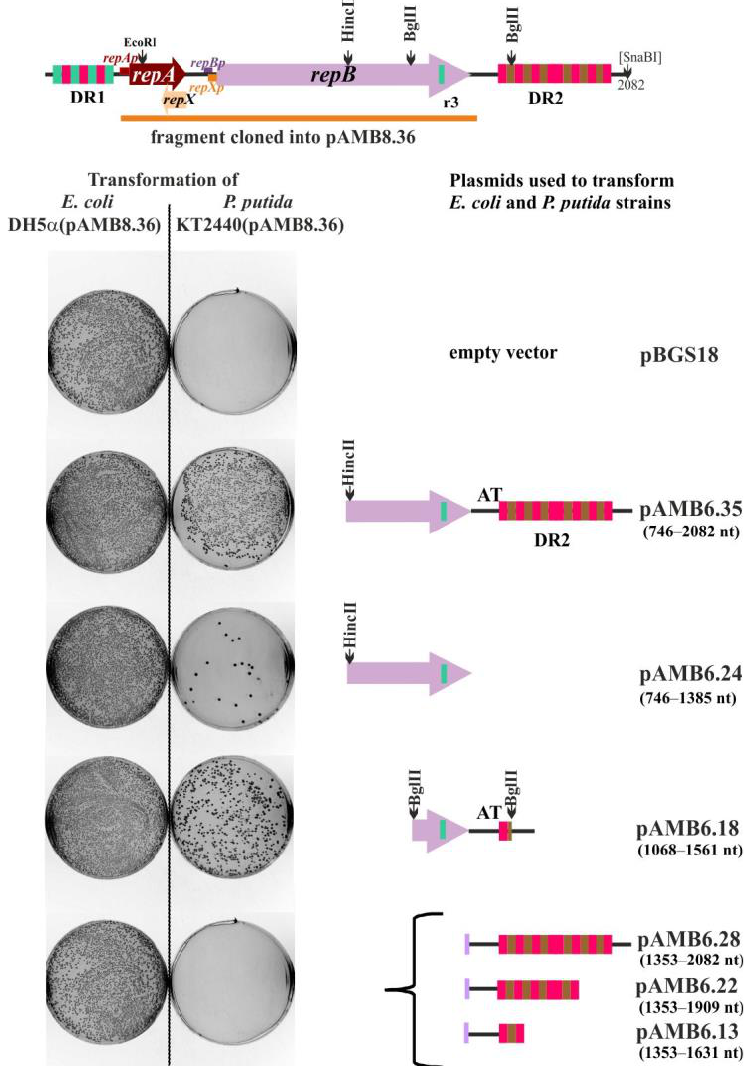
Figure 4. Mapping of the oriV RA3 region. DNA fragment encoding repA-1 and repB was cloned into the BHR vector (pAMB8.36) to be expressed in various hosts (upper scheme). The miniRA3-1 segments were cloned into pBGS18 as shown on the right. The same DNA quantities of the pBGS18 derivatives were used to transform the competent cells of E. coli DH5 α (as a control of transformation efficiency) and P. putida KT2440 derivatives carrying pAMB8.36. The empty pBGS18 is unable to replicate in P. putida strain. The efficiency of the transformation and growth of the double transformants is demonstrated on photographs of the transformation plates selective for both plasmids (left